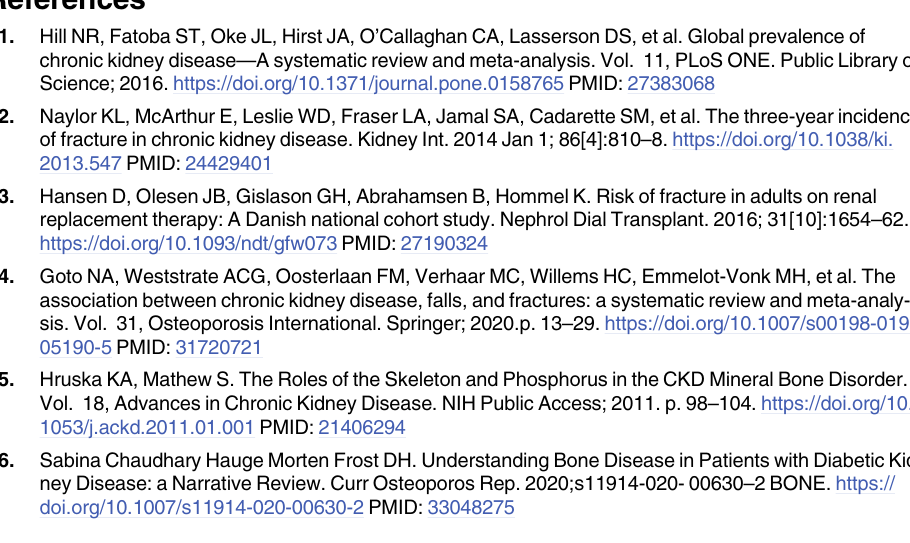
S1 Table. Cutoff-off points used for sarcopenia assessment and detailed quality assess-